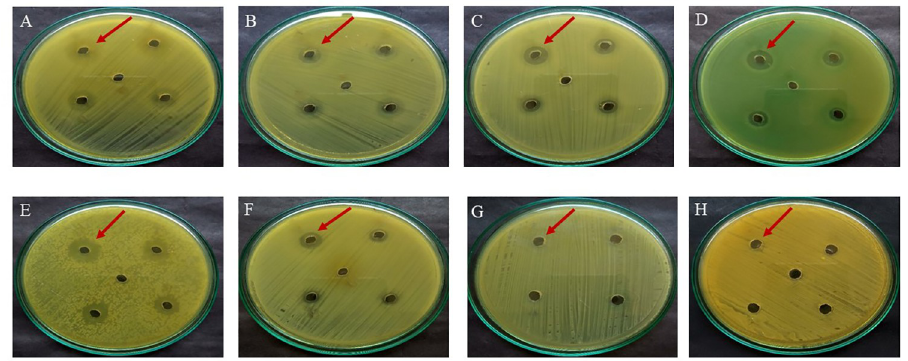
Fig 4. Antagonistic activity of P . pentosaceus OBK05 against human pathogens. (A) Bacillus subtilis , (B) E . coli , (C) Klebsiella pneumoniae , (D) Pseudomonas aeruginosa , (E) Salmonella typhi , (F) Staphylococcus aureus , (G) Lactobacillus acidophilus and (H) Saccharomyces cerevisiae . Arrows indicate the effect of OBK05 isolate on pathogens in the form of zone of inhibition (mm) around the wells. Experiments were performed in triplicates, and Data represented as the means ± S.D. of three independent experiments.